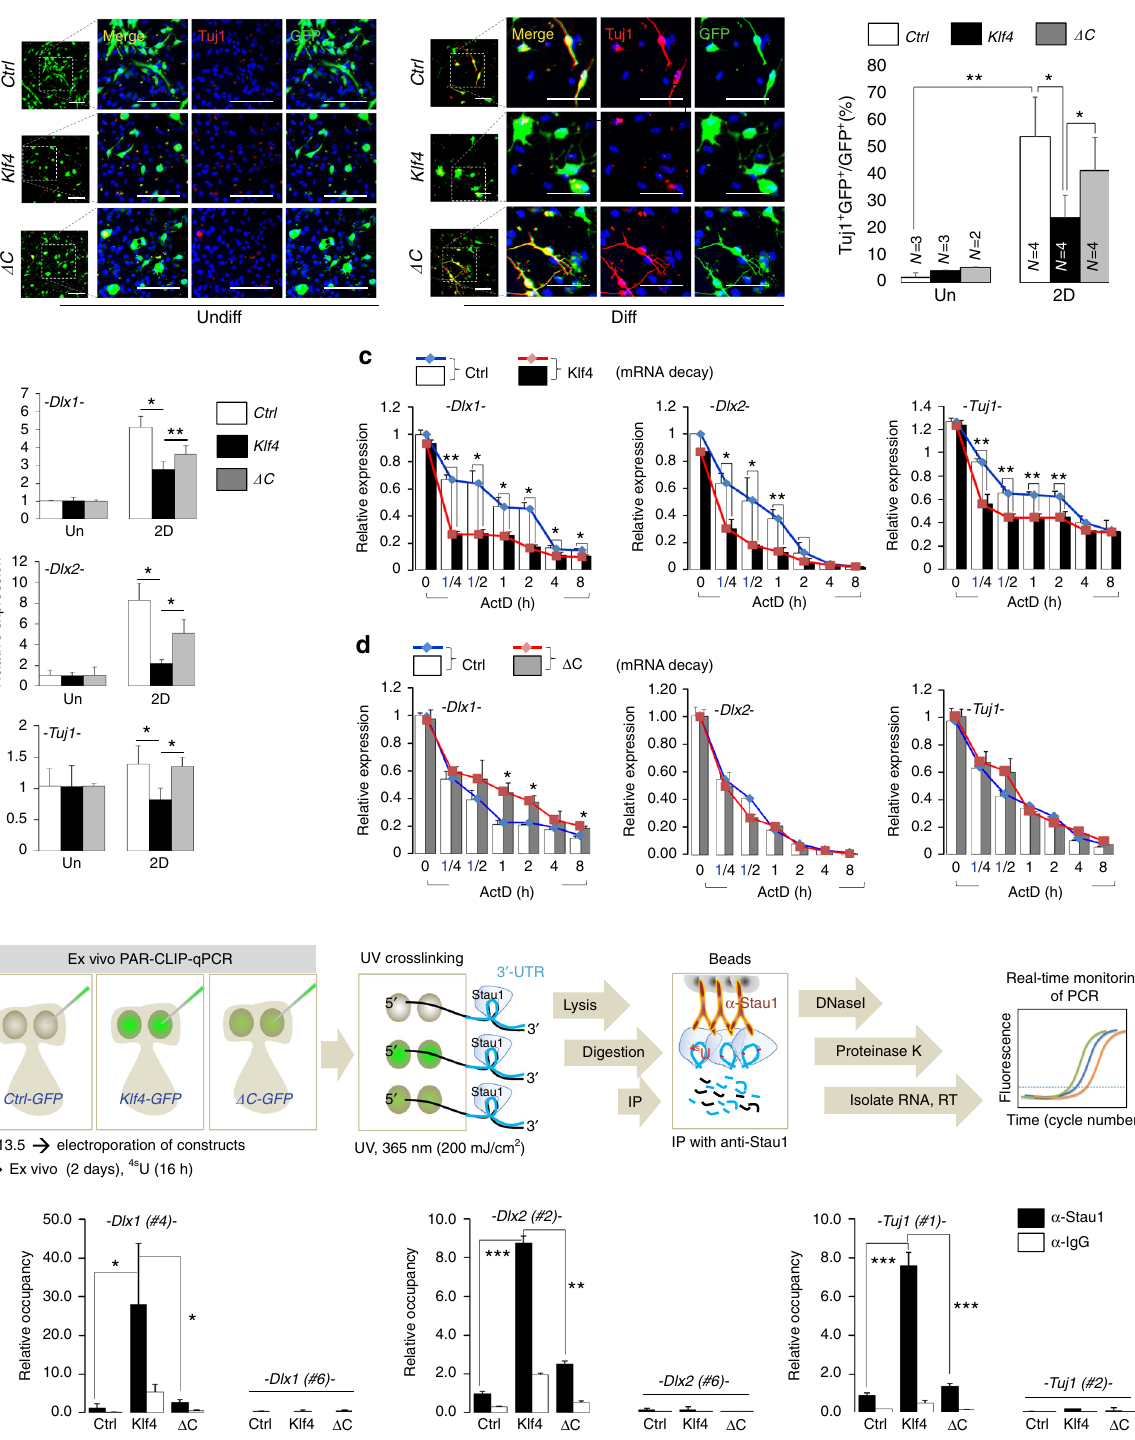
Fig. 7 Klf4 increases Stau1 occupancy on target mRNAs in cortex ex vivo. a (Left) NPCs were transfected with pEGFP-Control, pEGFP-Klf4, or pEGFP- Δ C vectors and grown for 0.2 or 2 days in N2 medium. Immunostaining to detect Tuj1 (red) or GFP (green) expression. DAPI (blue). Scale bar, 50 μ m. (Right) Quanti fi cation of results shown at right. b qPCR analysis of indicated transcripts in NPCs transfected with pEGFP-Control, pEGFP-Klf4, or pEGFP- Δ C constructs and cultured in undifferentiation (Un) conditions or for 2 days of differentiation (2D). a , b Data are presented as mean ± SD. ANOVA tests were performed to calculate signi fi cance (* P < 0.01, ** P < 0.001). See Supplementary Table 4. c , d NPCs transfected with full-length ( c ) or Δ C Klf4 ( d ) were treated with actinomycin D for indicated times and mRNAs were prepared for RNA stability assay ( n = 3). Results are normalized to control NPCs at 0 h. e Schematic showing the modi fi ed ex vivo PAR-CLIP protocol. Green images indicate GFP-labeled control, full-length Klf4 or Δ C expression in electroporated embryo brain. f PAR-CLIP-qPCR analysis in cortices electroporated with pEGFP-Control, pEGFP-Klf4, or pEGFP- Δ C constructs and grown in ex vivo condition for 2D. See also Supplementary Fig.